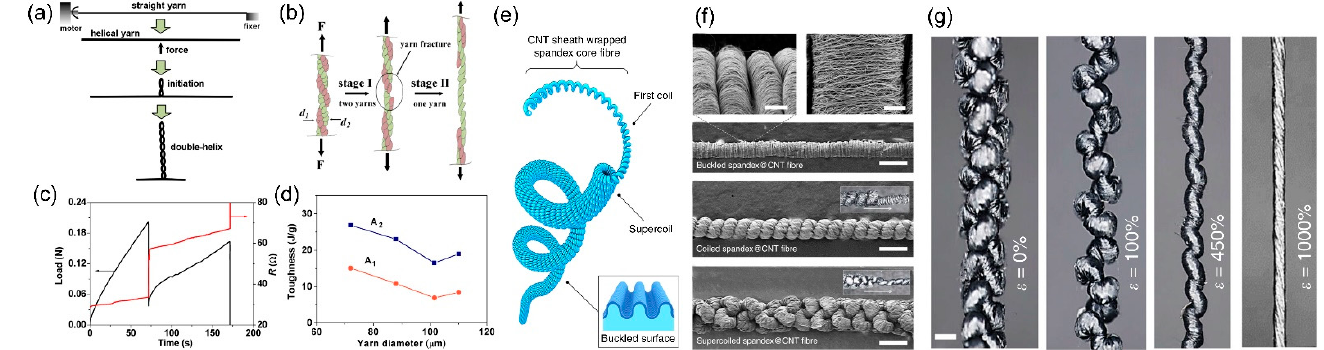
Figure 8. ( a ) Schematic of a spinning process from a straight yarn to a double-helix by loading in the middle section; ( b ) schematic of tensile test of double-helix yarns; ( c ) tensile load and electrical resistance vs. time for double-helix yarns of CNT; ( d ) the yarn diameter-dependent toughness of double-helix yarns at two stages during the stretching; Reprinted with permission from Ref. [82]. 2013, American Chemical Society. ( e ) schematic illustration of highly twisted CNT wrapped spandex fiber; ( f ) SEM images for noncoiled, first-coiled, and supercoiled spandex@CNT fibers with increasing number of twists; and ( g ) optical images for supercoil fiber showing gradual coil separation with increasing applied strain [83].